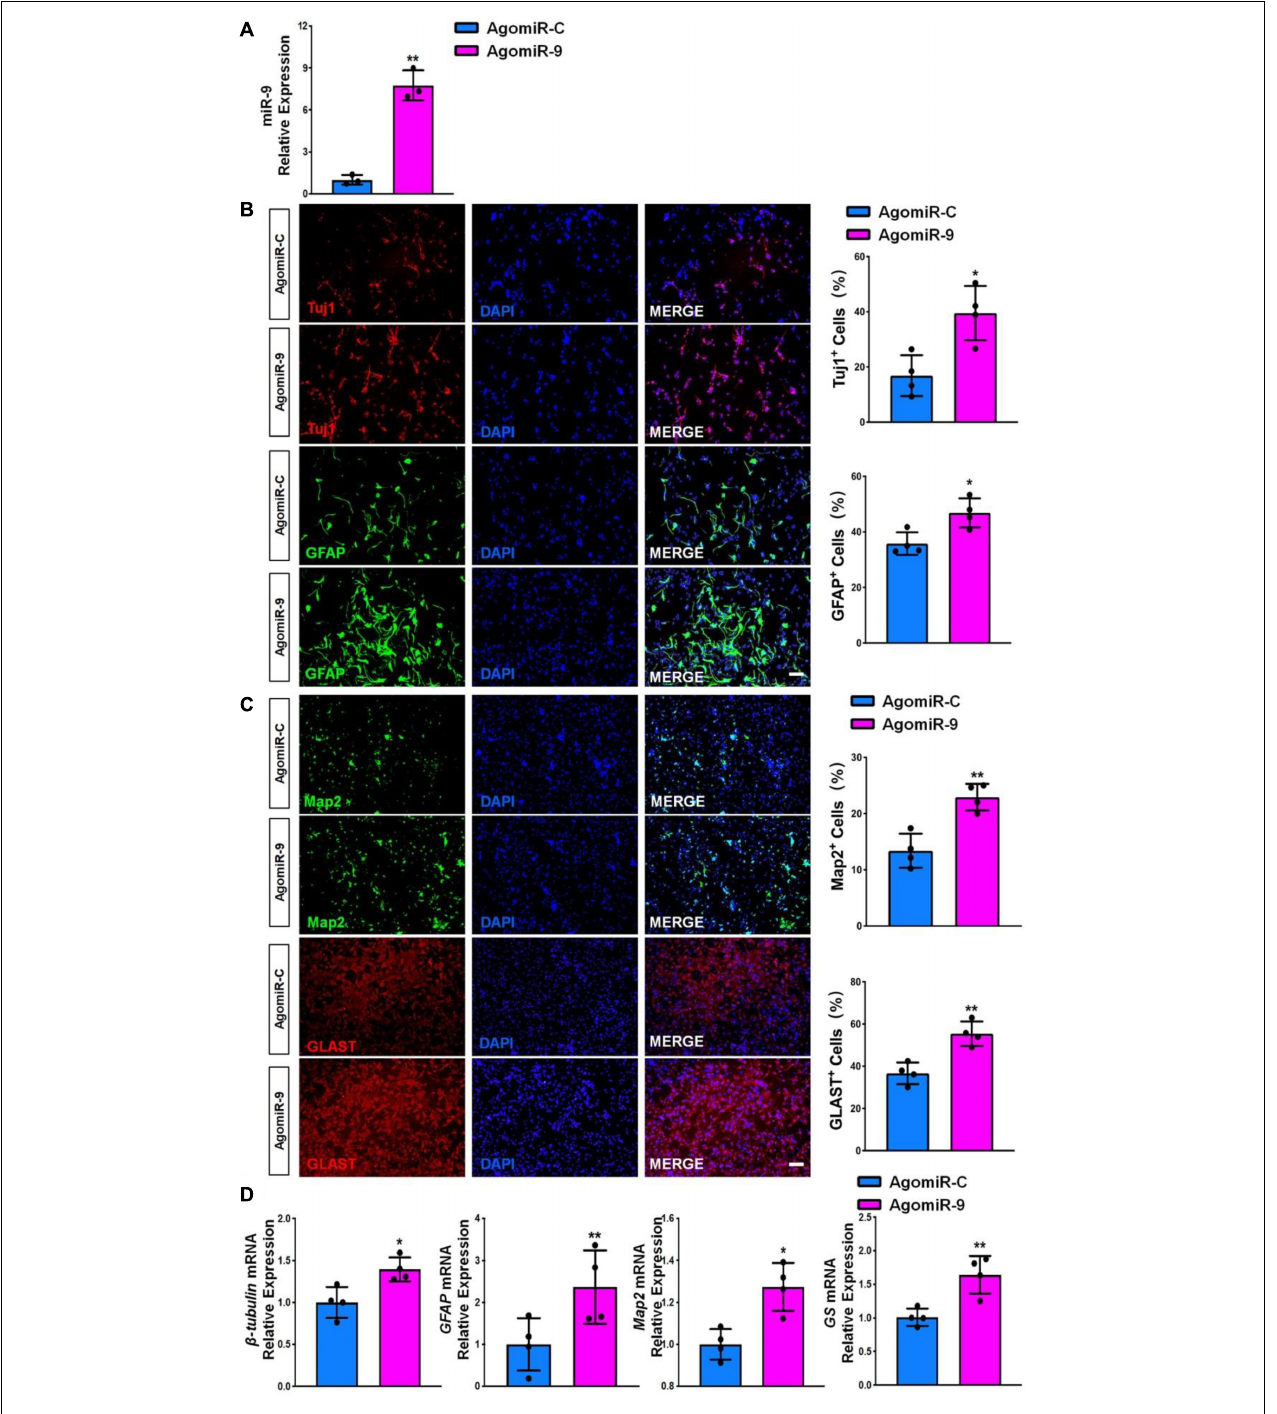
FIGURE 5 | miR-9 gain-of-function promotes NSC differentiation. (A) NSCs transfected with either agomiR-C or agomiR-9 were cultured for 6 days in differentiation conditions. The transfection efficiency was determined by quantifying the intracellular miR-9 expression levels via RT-qPCR analysis. (B) Representative images of pre-mature cell markers (Tuj1 and GFAP) staining were shown. Proportions of cells exhibiting immunoreactivities of pre-mature cell markers (Tuj1 + and GFAP + ) were determined (in the right panel). (C) Representative images of matured cell markers (Map2 and Glast) staining were shown. Proportions of cells exhibiting immunoreactivities of pre-mature cell markers (Map2 + and Glast + ) were determined (in the right panel). (D) The expression levels of transcripts corresponding to pre-mature cell markers ( β III-tubulin and GFAP ) and matured cell markers ( Map2 and GS ) was determined by RT-qPCR analysis. Data were represented as mean ± SE from three independent experiments. * and ** denote p < 0.05 and p < 0.01, respectively. Scale bar 100 µ m in panel (B,C) .